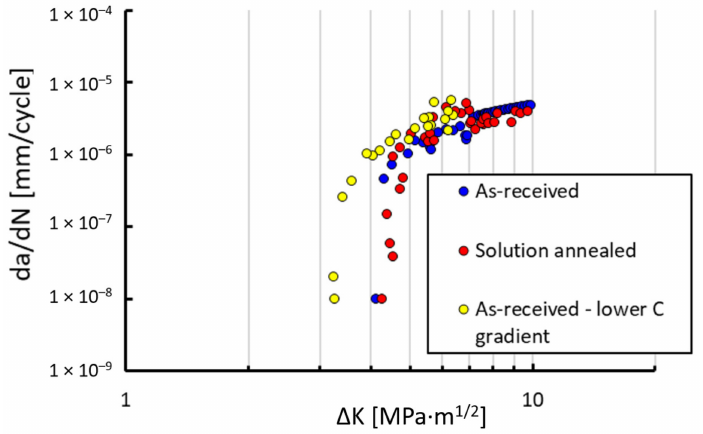
Figure 7. Measured crack growth rates da/dN at the load ratio R = 0.7 for the two microstructural states at the elevated temperature of 150 ◦ C. The yellow points correspond to the experiment with a lower load-shedding gradient C = − d ∆ K/da.